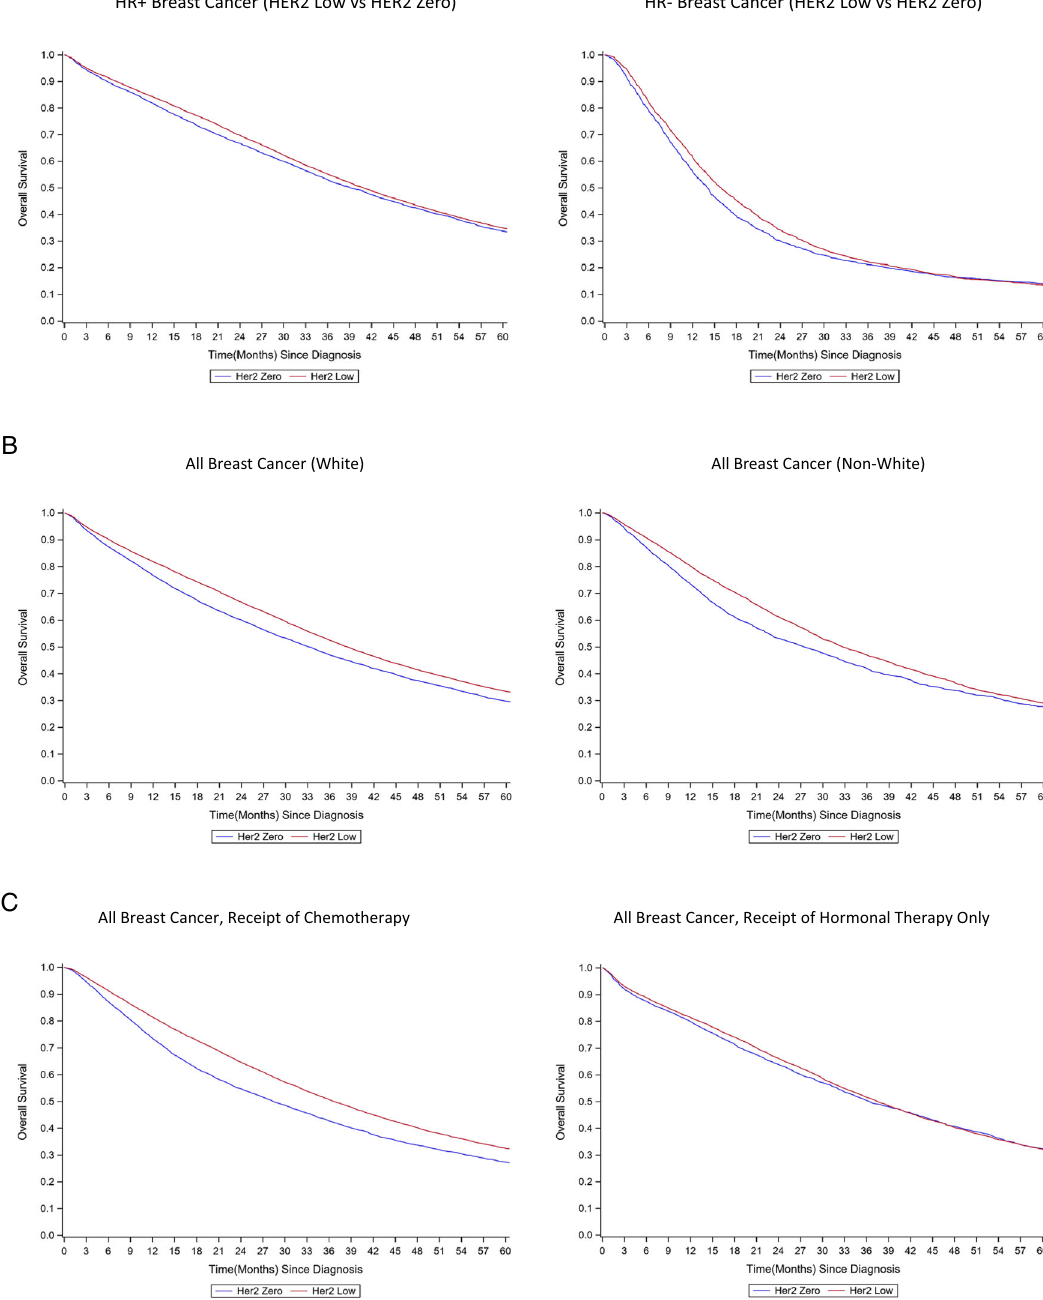
Fig. 3 Survival curve by level of HER2 expression and socio-clinical factors. A By hormonal receptor status: Left: HR + breast cancer (HER2 Low vs. HER2 Zero), p = 0.003; Right: HR − breast cancer (HER2 Low vs. HER2 Zero), p = 0.007. B By patients ’ race: Left: HR + breast cancer (White), p < 0.001; Right: HR − breast cancer (non-white), p < 0.001. C By type of treatment: Left: All breast cancer, receipt of chemotherapy, p < 0.001; Right all breast cancer, receipt of hormonal therapy only, p = 0.43. Log-rank test was used to compare the survival across HER2